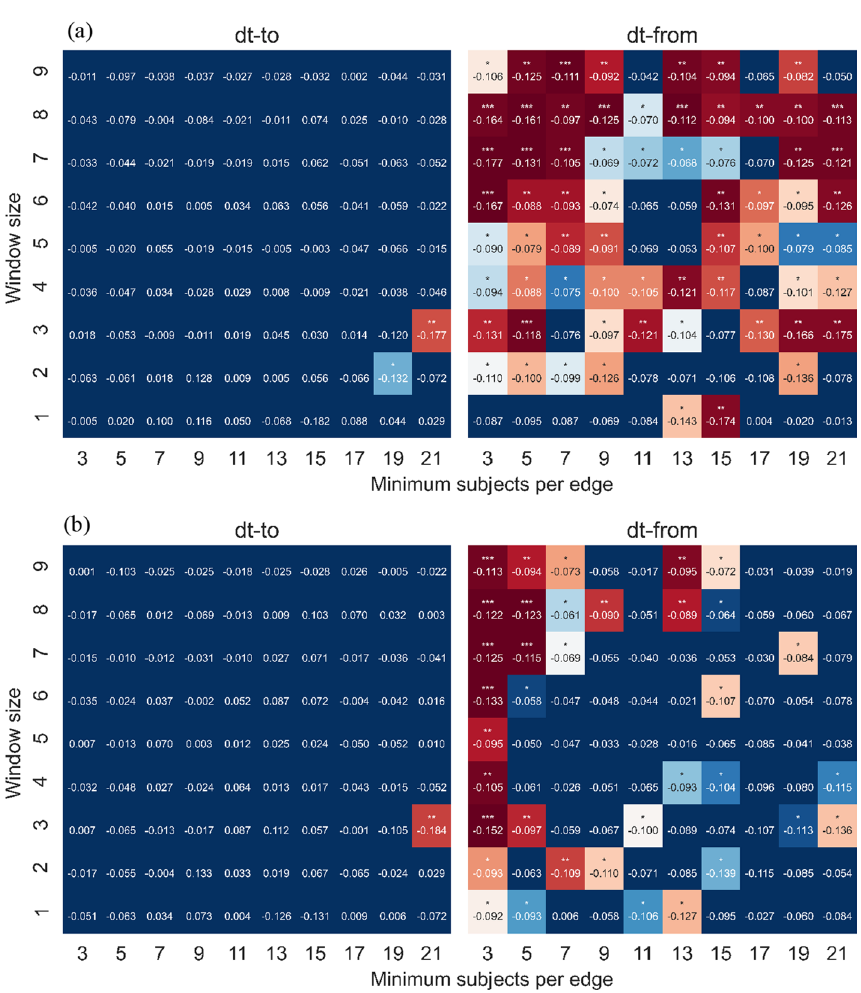
non-significant beta. By contrast, the redder the cell is, the greater the beta coefficient is. The number of stars indicates the level of significance. The a graphs reflect the model with the independent variables LDC and log-frequency; the b graphs reflect the model with the independent variables LDC and average